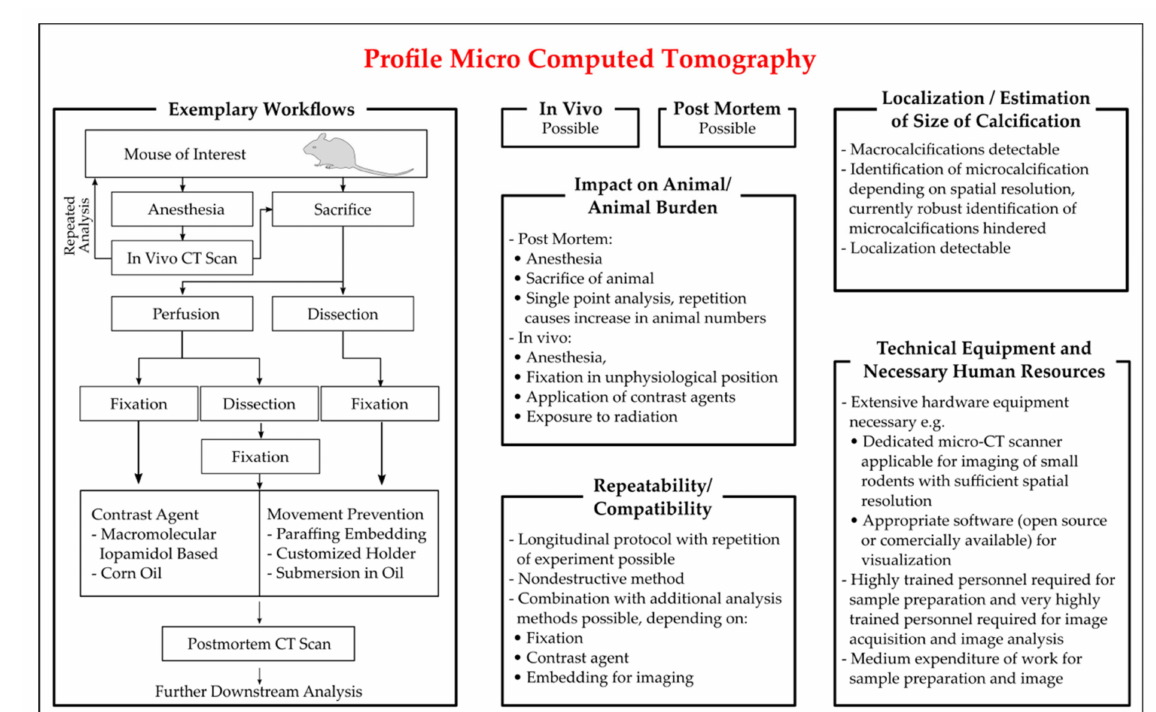
Figure 3. Characteristics of protocols of Micro-CT ( µ CT) employed for the detection of vascular calcification in mice. Key aspects for the critical appraisal of the applicability of µ CT are summarized with regards to the applicability of µ CT in vivo and ex vivo, the location and size of vascular calcification identifiable by µ CT, the repeatability of read out in longitudinal studies, the compatibility with additional methods and the personal and technical expanse. The exemplary workflow presented is based on the publications of